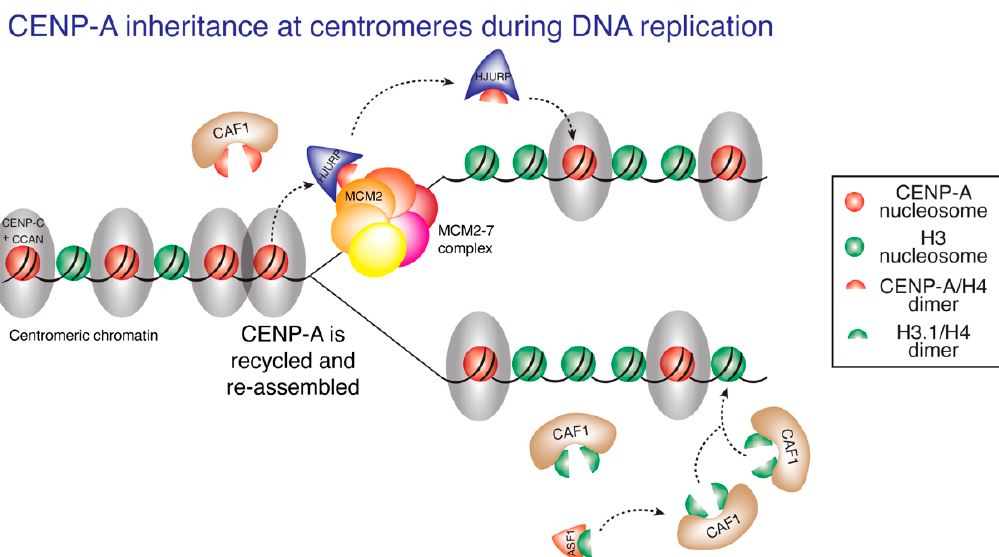
Figure 2. CENP-A inheritance during DNA replication. Presence of the constitutive centromere- associated network (CCAN) complex at centromeric chromatin tethers CENP-A in close proximity to the centromeric DNA replication fork and promotes stable interaction between CENP-A and MCM2. The coordinated action of MCM2, HJURP and CAF1 enables recycling of CENP-A:H4 dimers and their reassembly onto the daughter centromeres, preserving centromere identity.